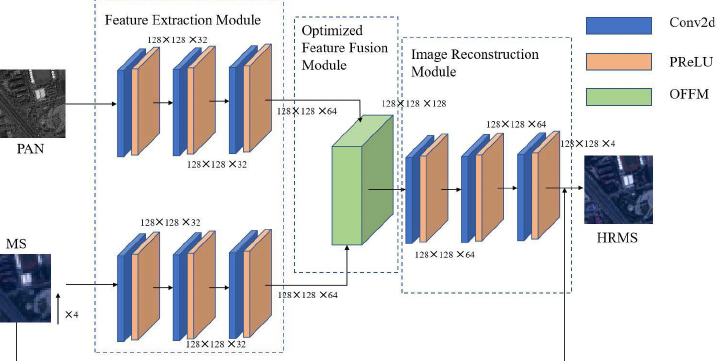
Figure 1. The overall framework diagram of the dual-branch remote sensing image fusion network based on the attention mechanism to optimize feature fusion. The inputs are MS and PAN images, and the output is HRMS. The network architecture is mainly composed of the following three sub- modules: (1) feature extraction module; (2) optimized feature fusion module (OFFM); and (3) image reconstruction module.